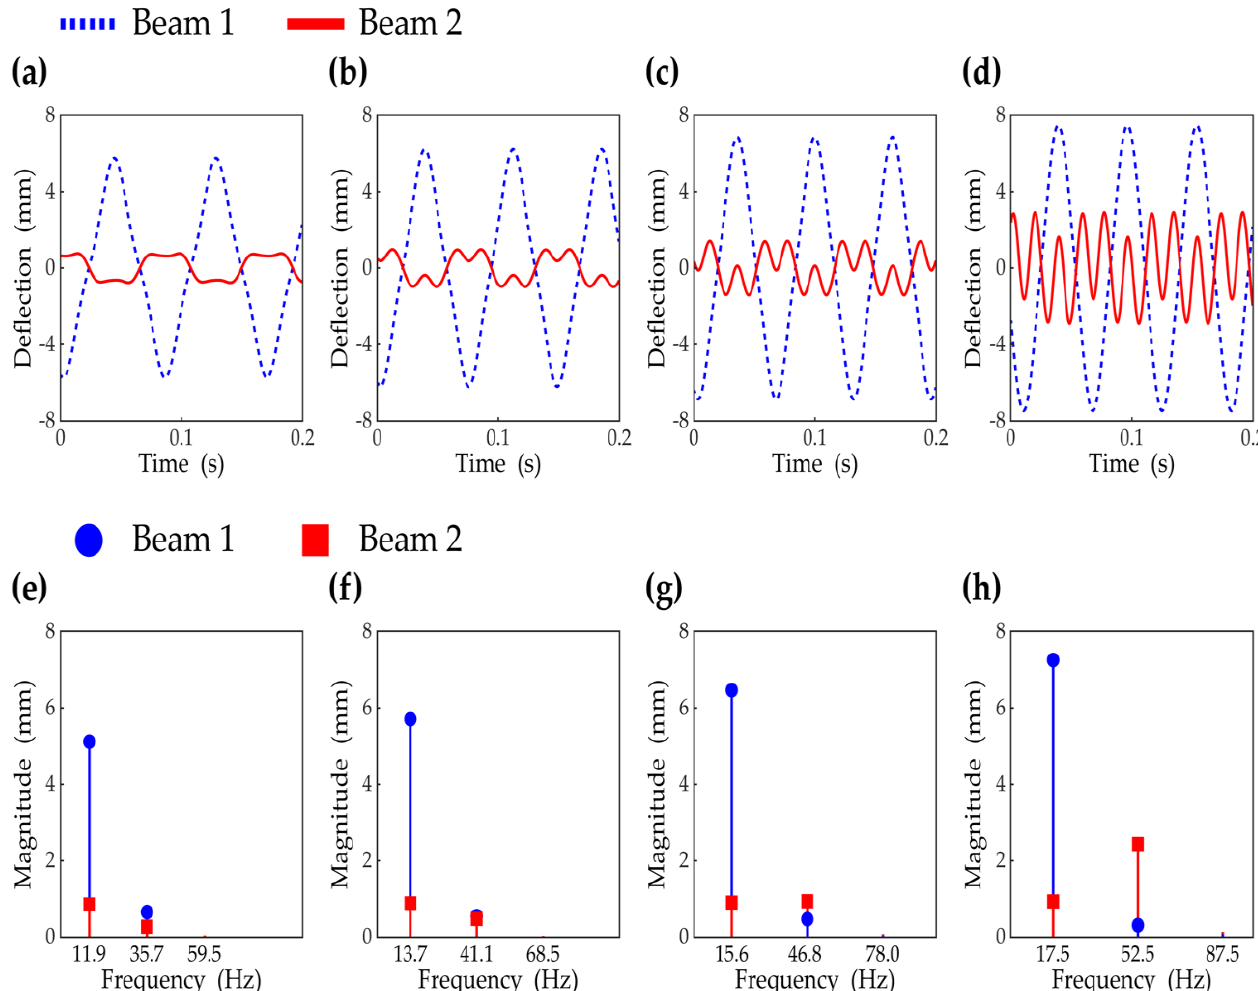
Figure 5. The steady-state interwell responses of the two piezoelectric bimorph beams are shown. ( a – d ) are the time responses obtained when the excitation frequencies are 11.9 Hz, 13.7 Hz, 15.6 Hz, and 17.5 Hz, respectively, which belong to the frequency region of the first primary resonance. The amplitude of the excitation is 6 m/s 2 . The magnitudes of the harmonic components in the time responses ( a – d ) are plotted in ( e – h ). It is observed that the magnitudes of the fifth harmonic terms are negligible for all the cases ( e – h ).